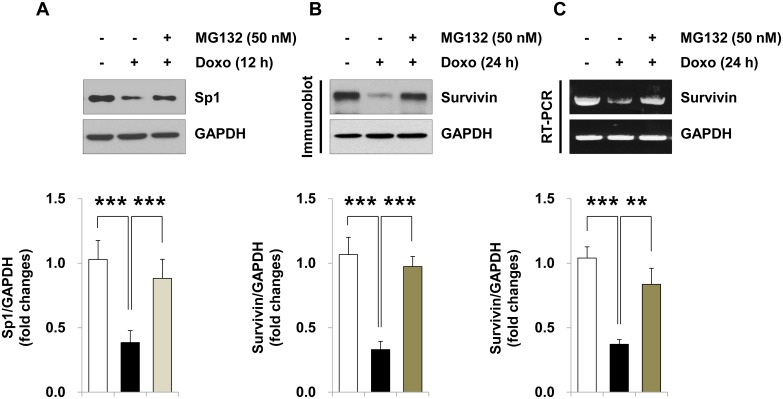
Doxorubicin-induced Sp1 degradation by proteasome-mediated proteolysis.(A–C) H9c2 cardiac myocytes were pretreated with proteasome inhibitor MG132 (50 nM) for 1 h and treated with 1 μM doxorubicin (Doxo) for either 12 h (A) or 24 h (B, C). (A, B) Whole cell lysates were analyzed by immunoblotting using anti-Sp1 and anti-survivin antibodies. Graphs represent the mean ±S.D. of the normalized densitometric analyses of Sp1 (A, n = 5) or survivin (B, n = 5) protein levels (***p < 0.001). (C) Total RNA was analyzed by RT-PCR (28 cycles) with specific primers to survivin gene. Graph represents the mean ±S.D. of the normalized densitometric analysis of survivin mRNA levels (**p < 0.01; ***p < 0.001, n = 3).